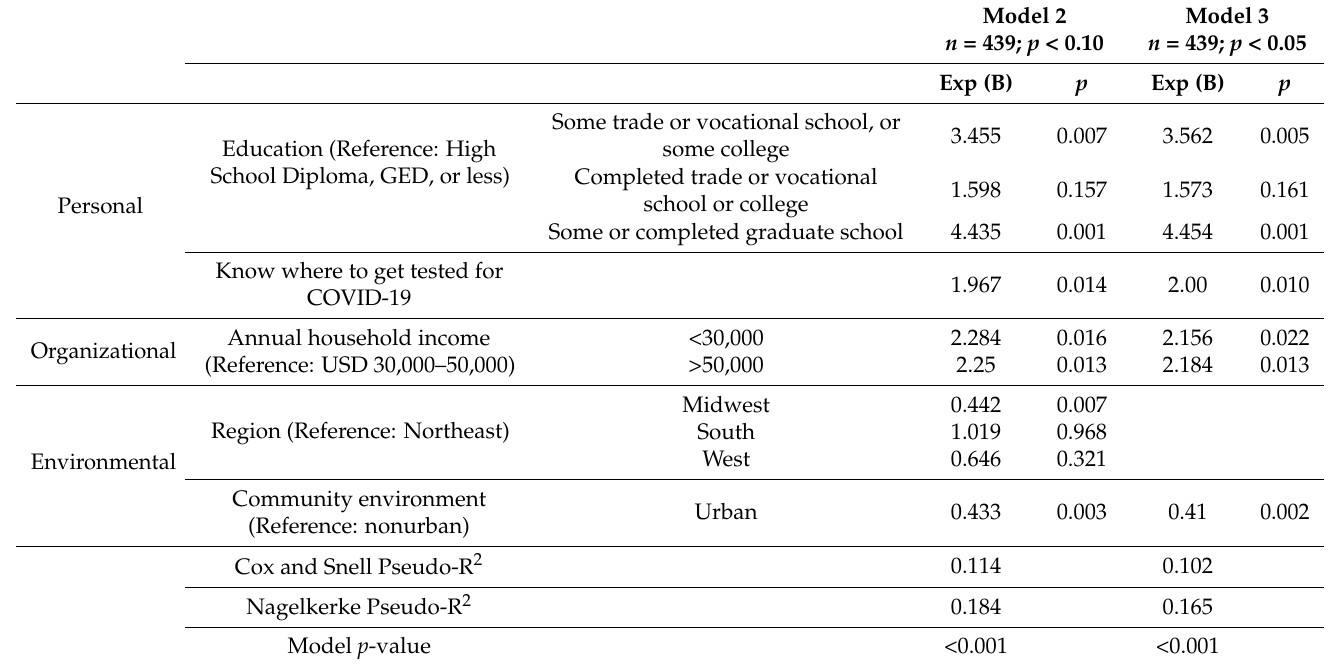
Table 5. Binary logistic regressions for outcome 3, wearing a face mask in